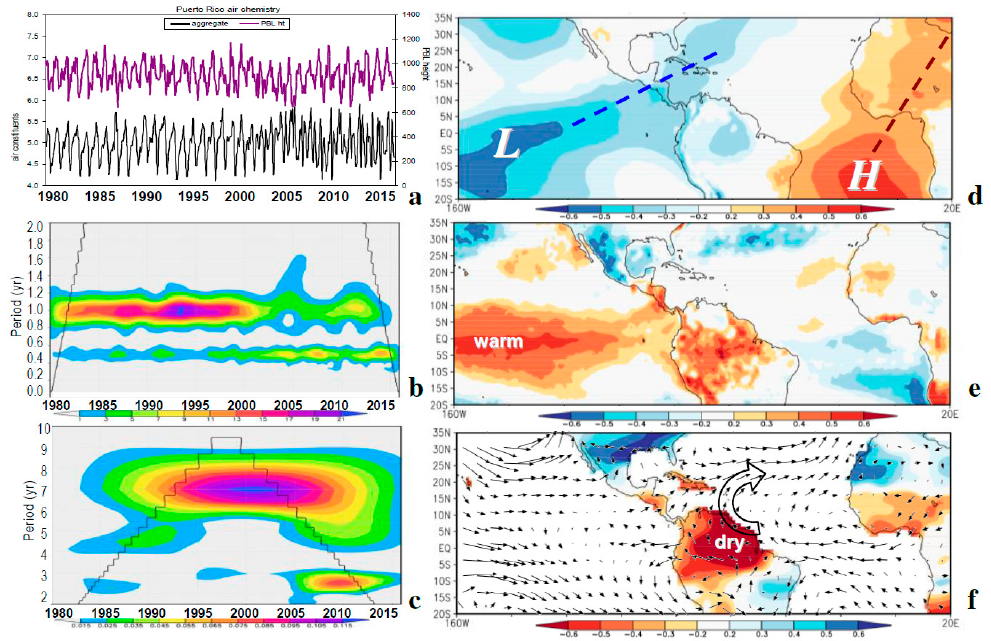
Figure 4. ( a ) Monthly time series of model-derived Puerto Rico air index and PBL height. Air index wavelet spectra ( b ) unfiltered and ( c ) 18-month smoothed, with cone of validity. Correlation maps of December–May air index with respect to: ( d ) MERRA2 air pressure, ( e ) surface temperature, and ( f ) GRACE soil moisture and 1000–850 hPa layer wind (correlation vectors, max = 1).